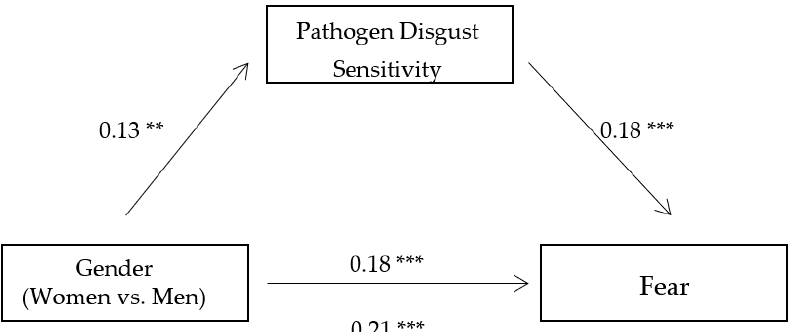
Significance of the standardized regression coefficients is indicated (** p < 0.01 and *** p < 0.001).